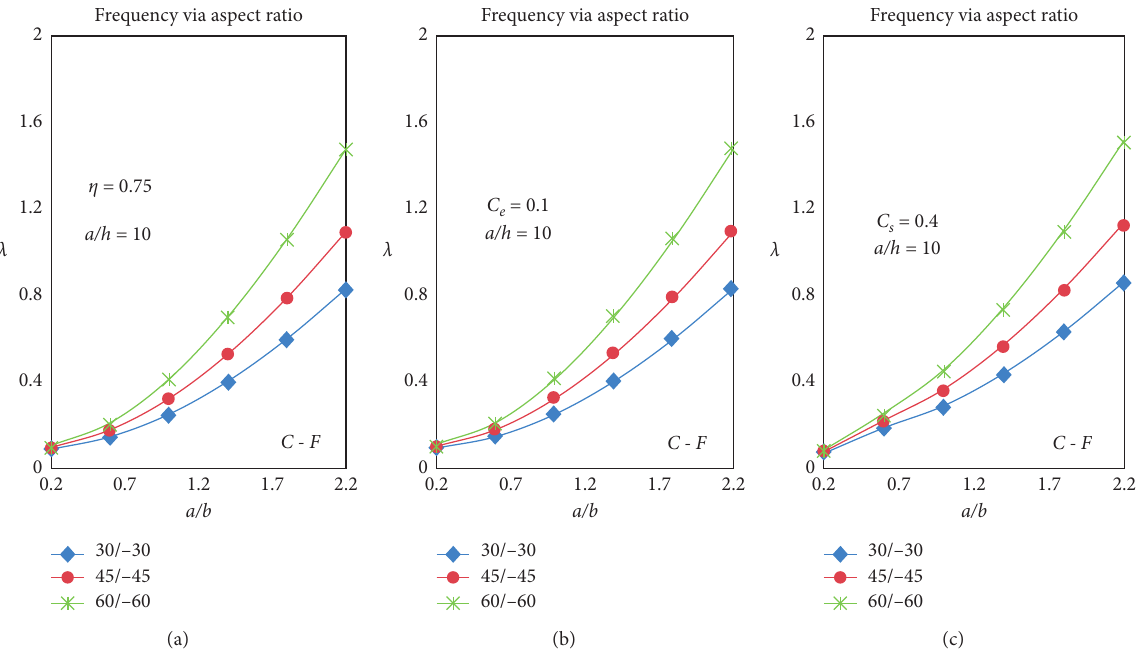
Figure 14: Influence of aspect ratio on frequency parameter value of 2-layered plates under C-F support